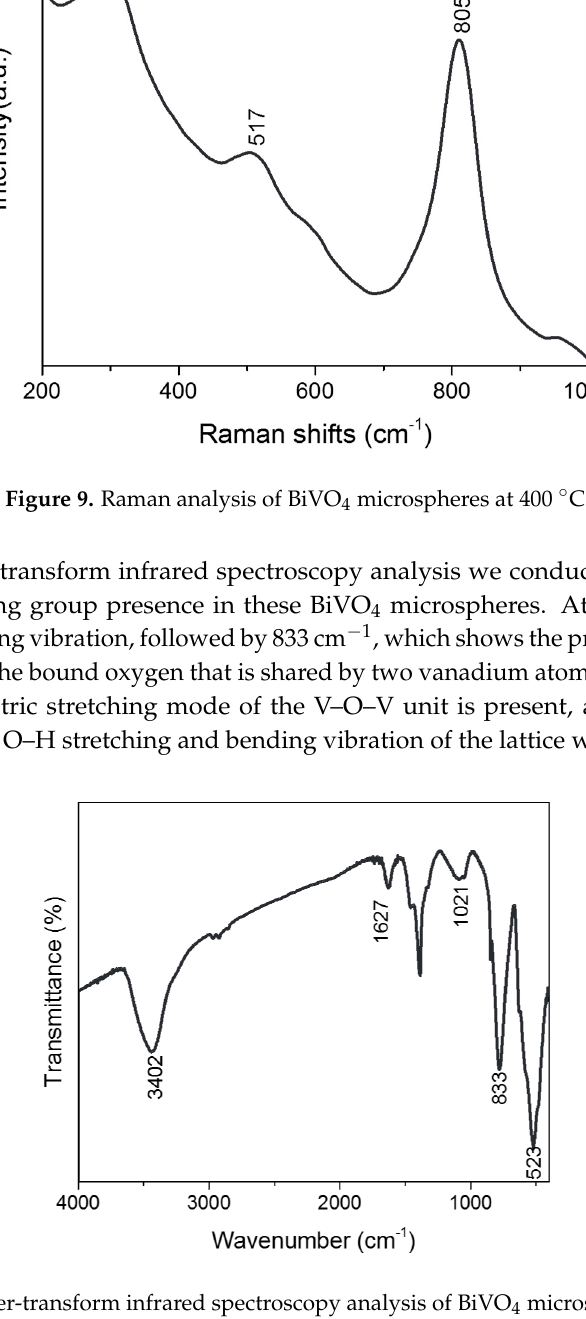
Figure 10. Fourier-transform infrared spectroscopy analysis of BiVO 4 microspheres at 400 °C.